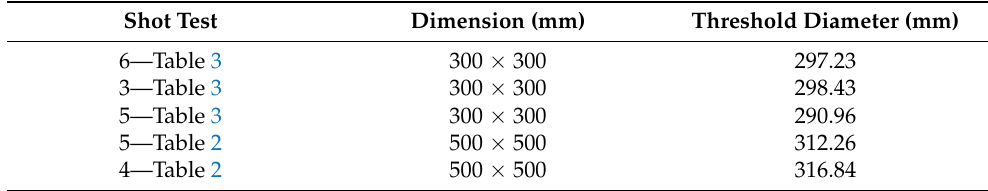
Table 5. Threshold diameters.